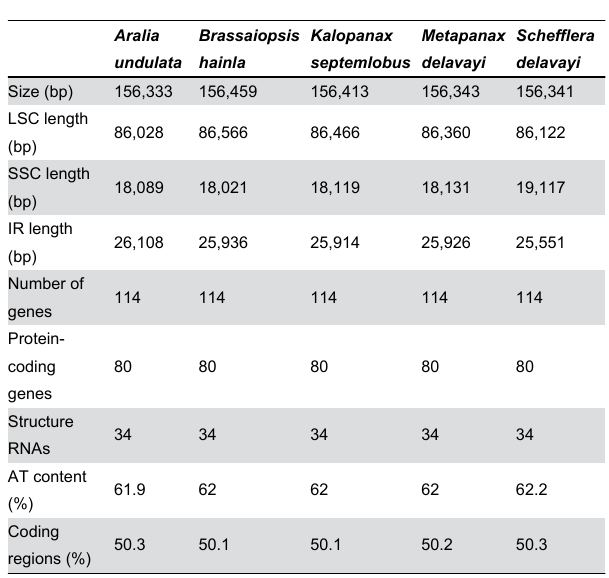
Table 2. Summary of the chloroplast genome features. Table 3. Genes contained in chloroplast genomes (114 genes in total).